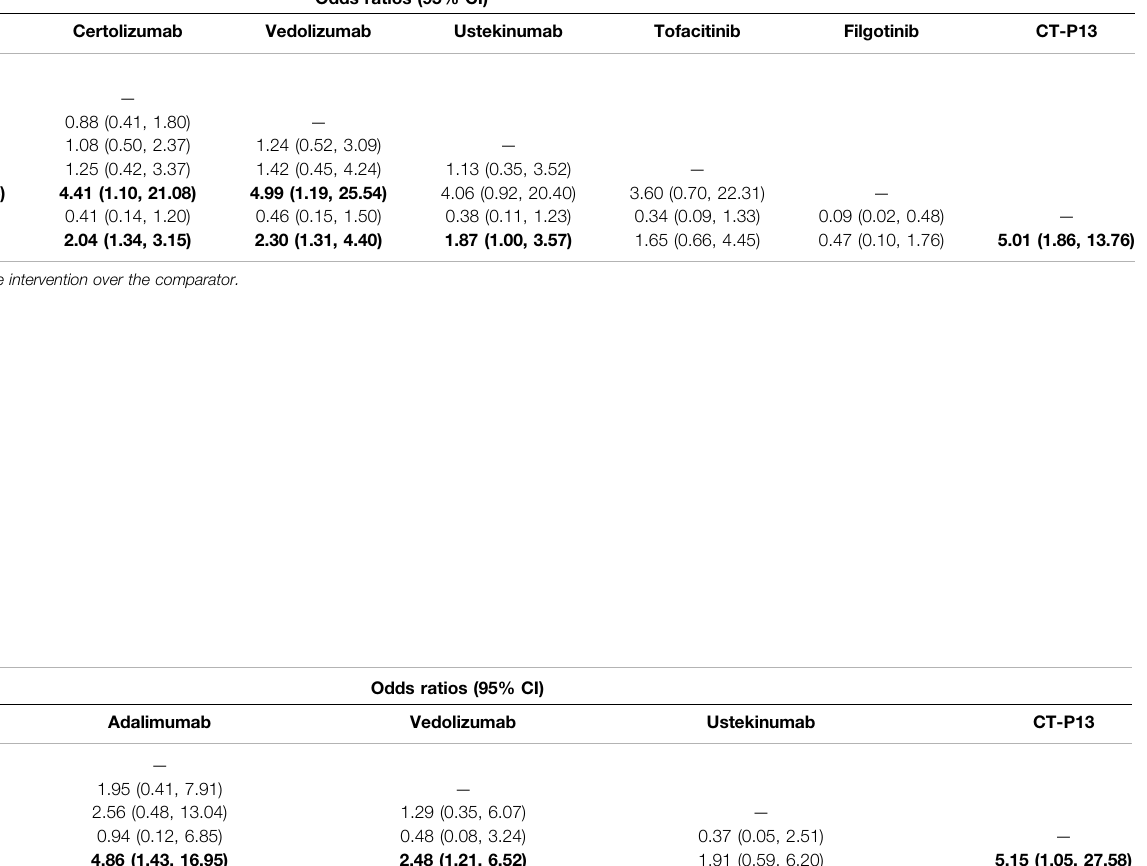
TABLE 3 | Pairwise comparisons of maintenance of remission. Intervention